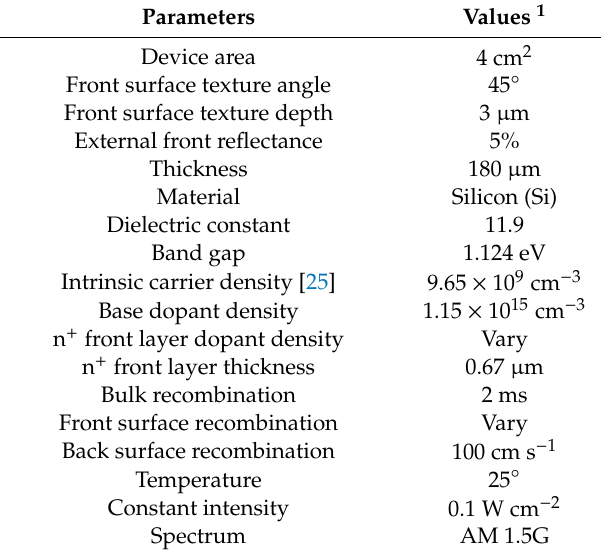
Table 1. Parameters for this simulation work.